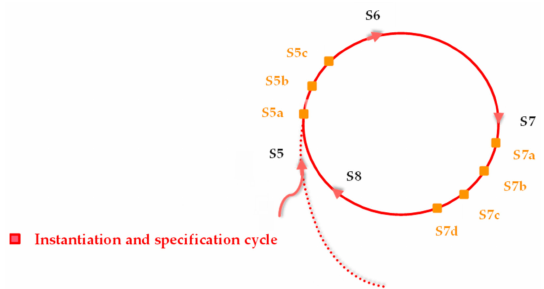
Figure 8. Sample alteration (increase) in the number of stages for teacher